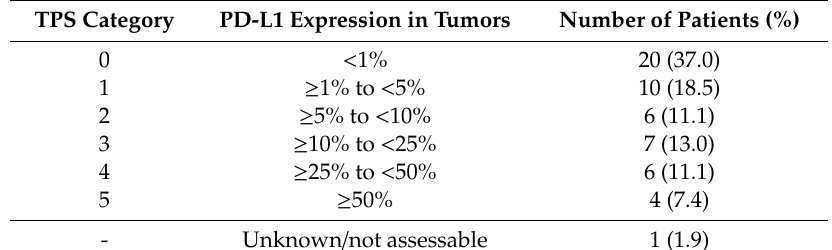
Table 2. Evaluation of the PD-L1 expression with the tumor proportional score (TPS).